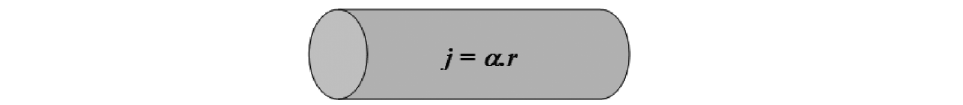
FIG. 6. The current problem